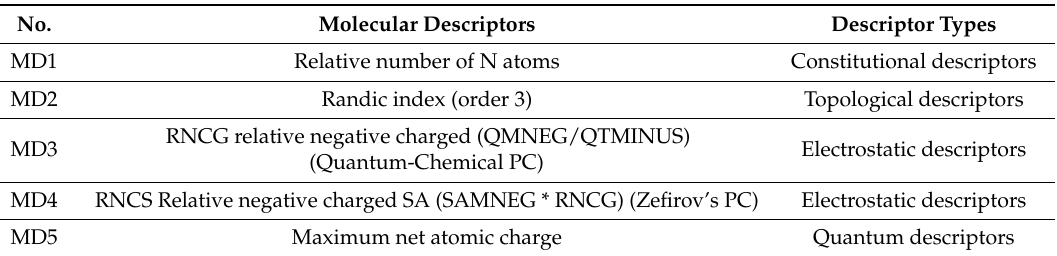
Table 2. Molecular descriptors selected by the chaos-enhanced accelerated particle swarm optimization algorithm (CAPSO)